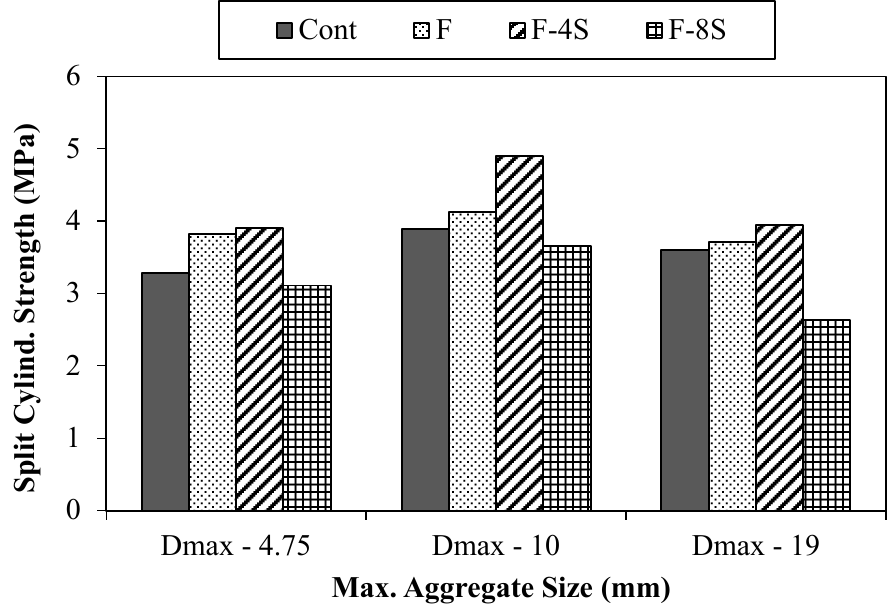
Figure 10. Split cylinder tensile strength results.